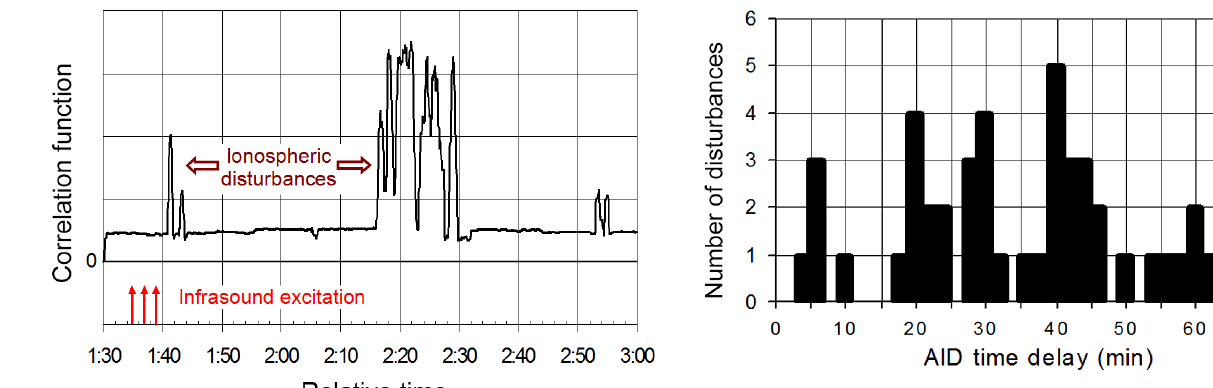
Figure 7. A histogram of the time delay of the ionospheric re- sponse relative to the start of the acoustic generation. According statistical processing results, a series of time delay variations in the detected atmospheric effects have been obtained: 5 . 8 ± 0 . 5min, 20 . 7 ± 2 . 3min, 29 . 3 ± 1 . 3min, 41 . 7 ± 2 . 3min, and 59 . 6 ± 4 .